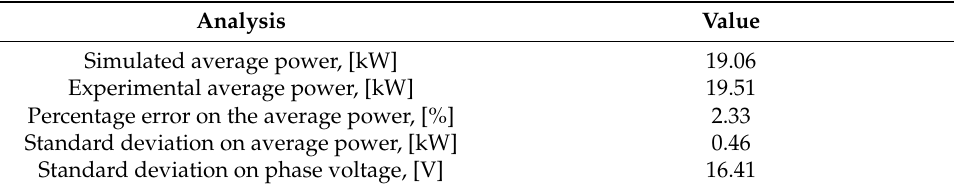
Table 2. Error analysis of the WEC model with the experimental results cited from